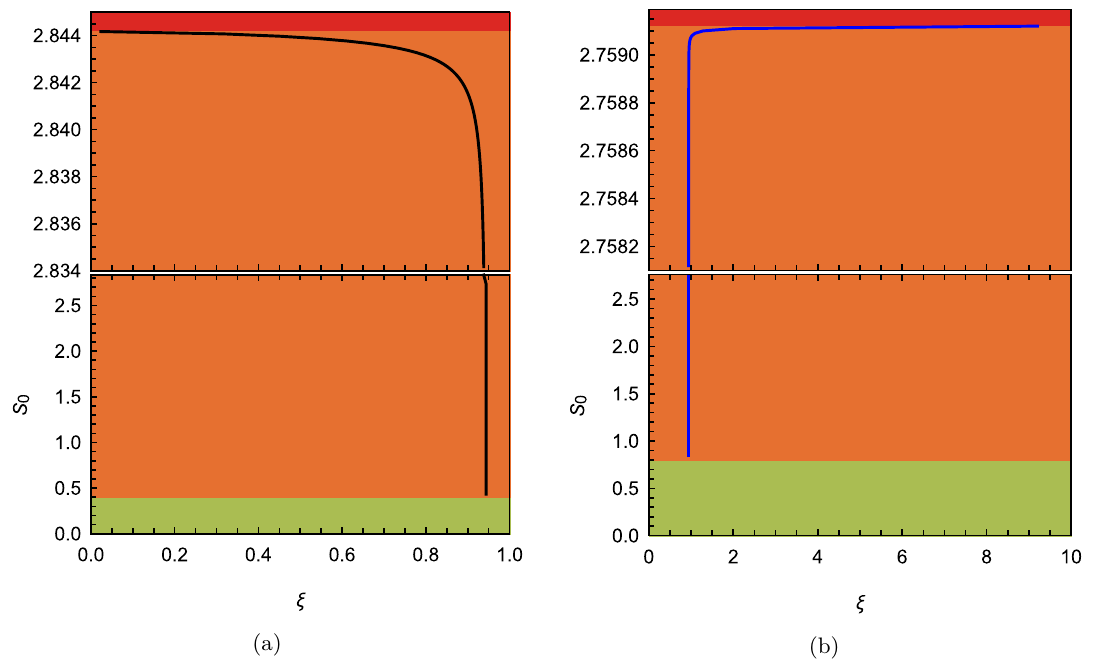
solutions. The black/blue curve in figure 1 , 0